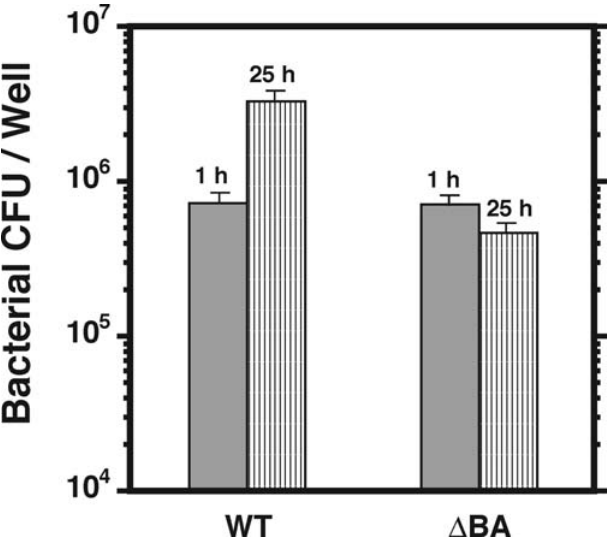
Figure 4. The D BA Mutant Is Defective in Survival and Replication within Macrophages The J774A.1 cell line was infected with an equal number of 28 8 C–grown log-phase wild-type (WT) or D BA strain of Y. pseudotuberculosis . Extracellular bacteria were removed and intracellular bacteria were enumerated at 1 h and 25 h post infection as described in Materials and Methods. Error bars indicate standard deviations of triplicate samples. DOI: 10.1371/journal.ppat.0020006.g004